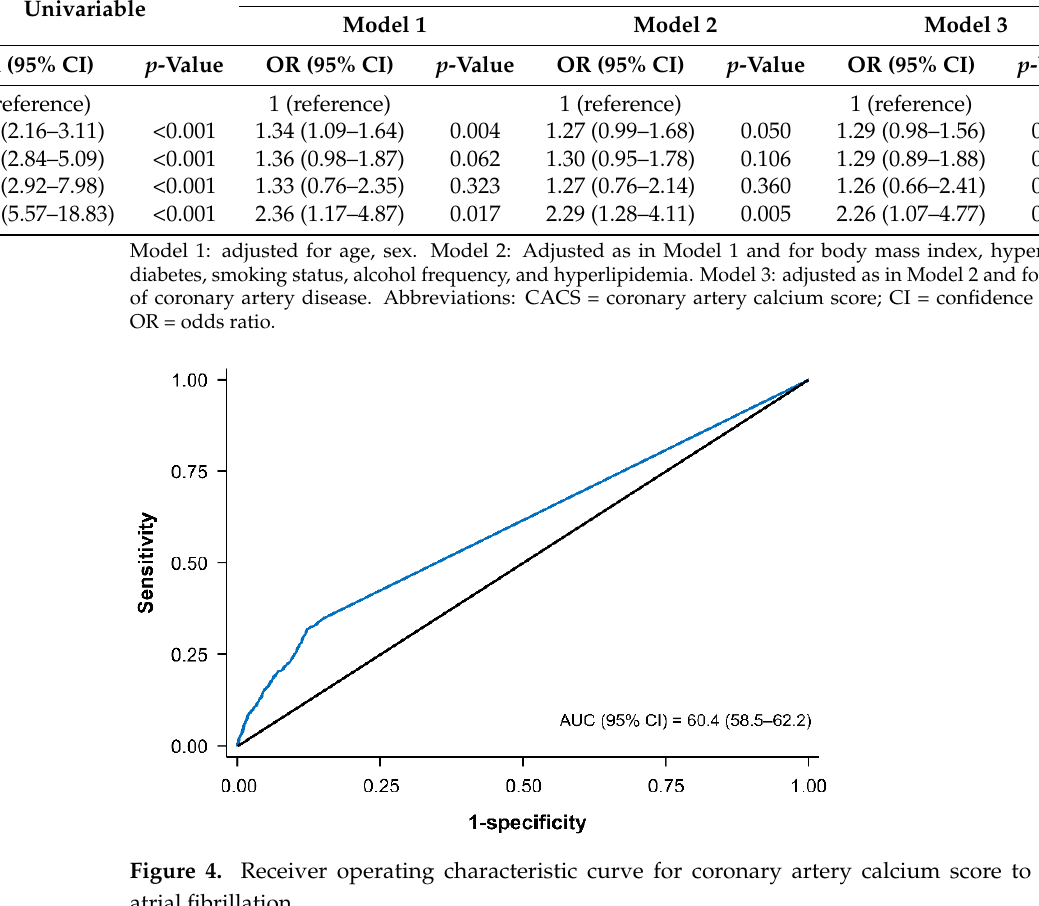
Table 2. Multivariable logistic regression analyses for the relationship of coronary artery calcium score and atrial fibrillation in total 143,529 participants.